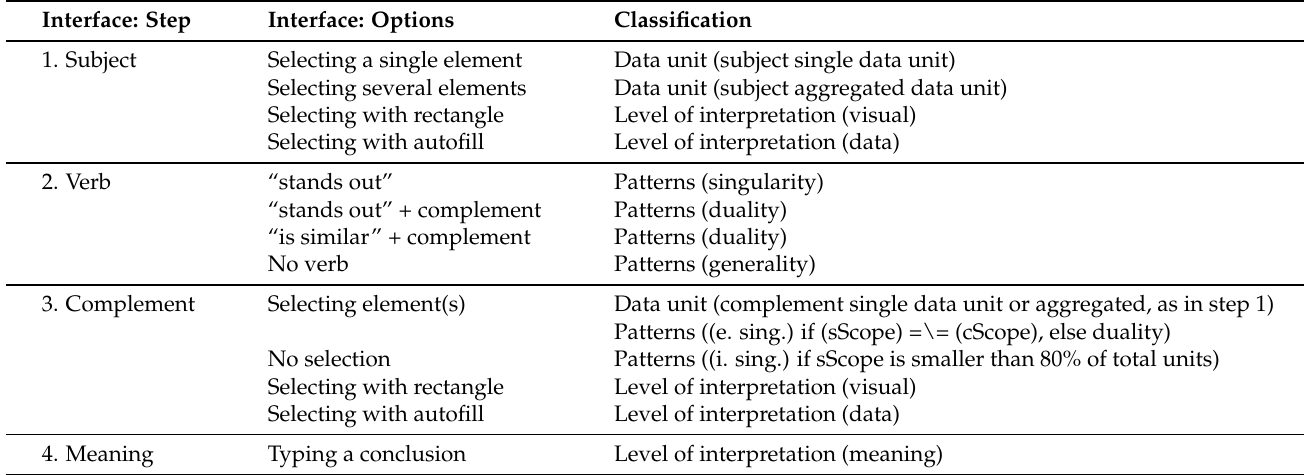
Figure 5. The annotation interface, in floating window mode. The rectangular selection is visible on the visualization (left part of the figure). Selected units are listed in the “Subjects” area, and the annotator is currently naming this set of units “Rightmost characters”, as seen in the “Name of the group” area. Table 1. Correspondence between the interface and the classification. The first column indicates a step within the stepper; the second column indicates certain values or selections made during the step; the third column shows the dimensions covered by the